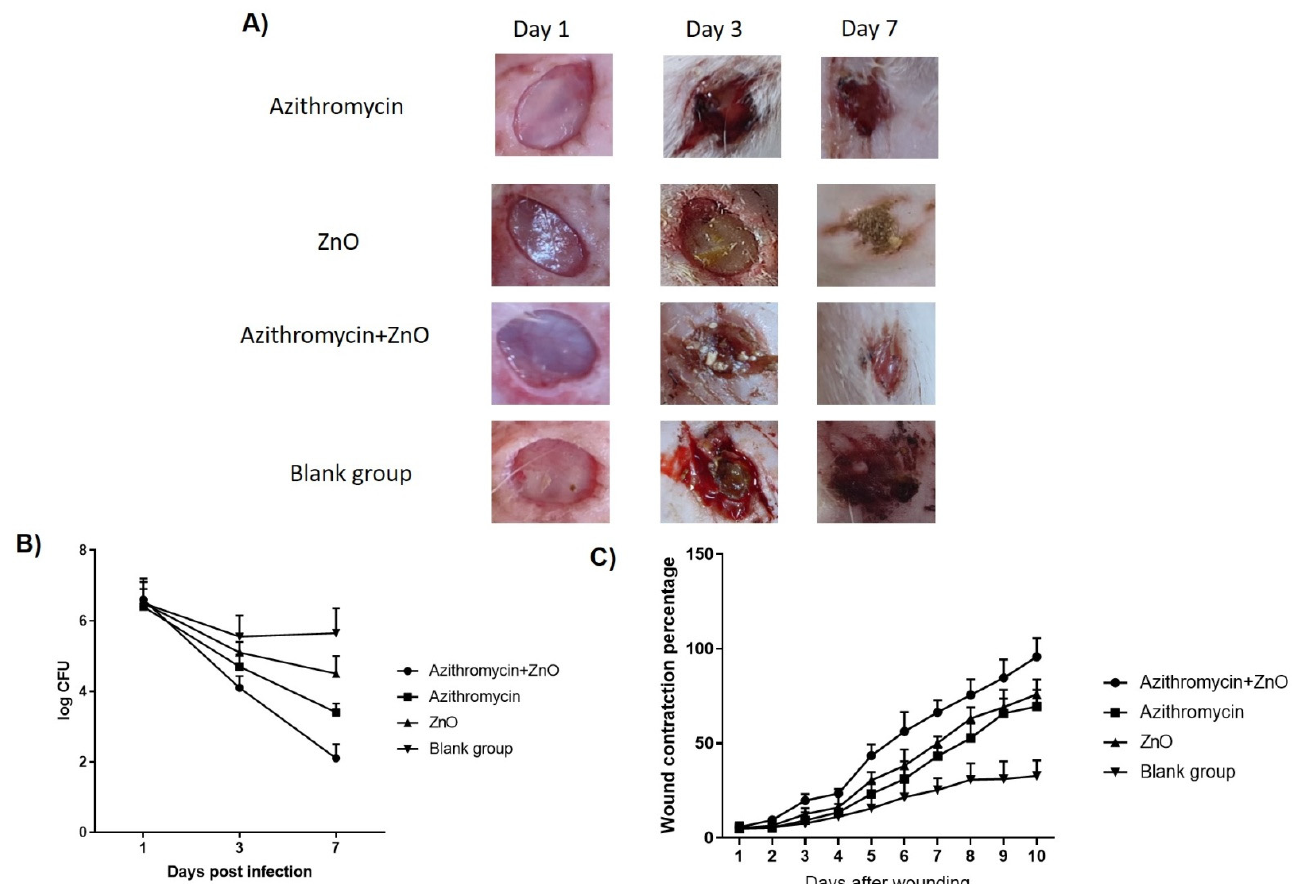
Figure 9. In vivo analysis of the tested preparations. ( A ) Wounds of rats were inoculated with MRSA and treated with indicated preparations then photographed at 1, 3, and 7 days post infection to visualize the healing process. ( B ) Bacterial load burden was evaluated in the wounded skin at 1, 3, and 7 days post infection. The results are expressed as the means ± SD. CFU, colony forming units. ( C ) Effect of AZM, ZnO, and AZM-ZnONPs on the percentage of wound contraction was evaluated over a duration of 10 days after infection.